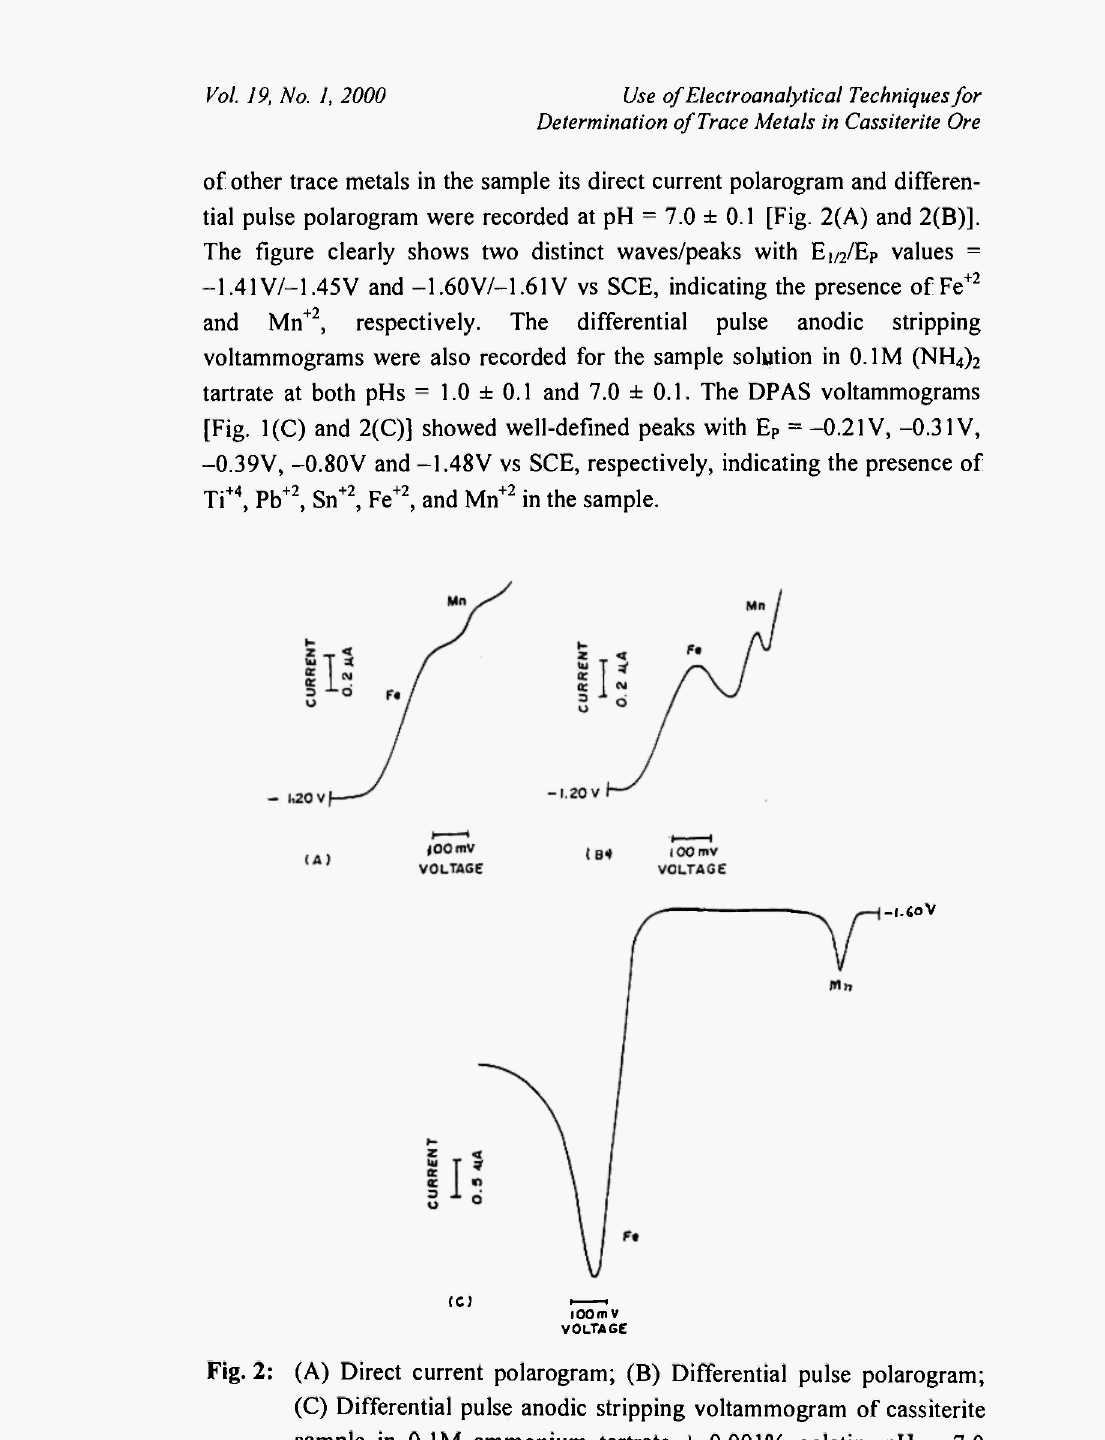
Fig. 2: (A) Direct current polarogram; (B) Differential pulse polarogram; (C) Differential pulse anodic stripping voltammogram of cassiterite